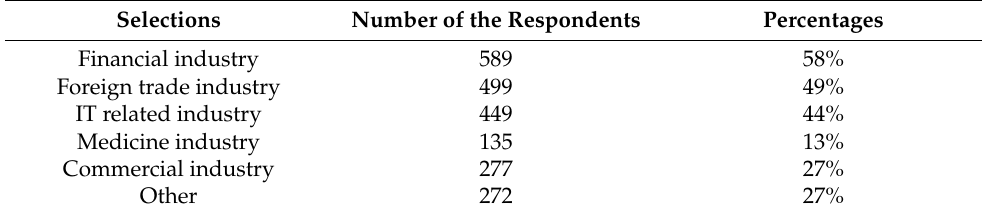
Table A24. Do you think which industry can be selected as the first industry to use cryptocurrencies in the pilot FTZs (multiple-choice